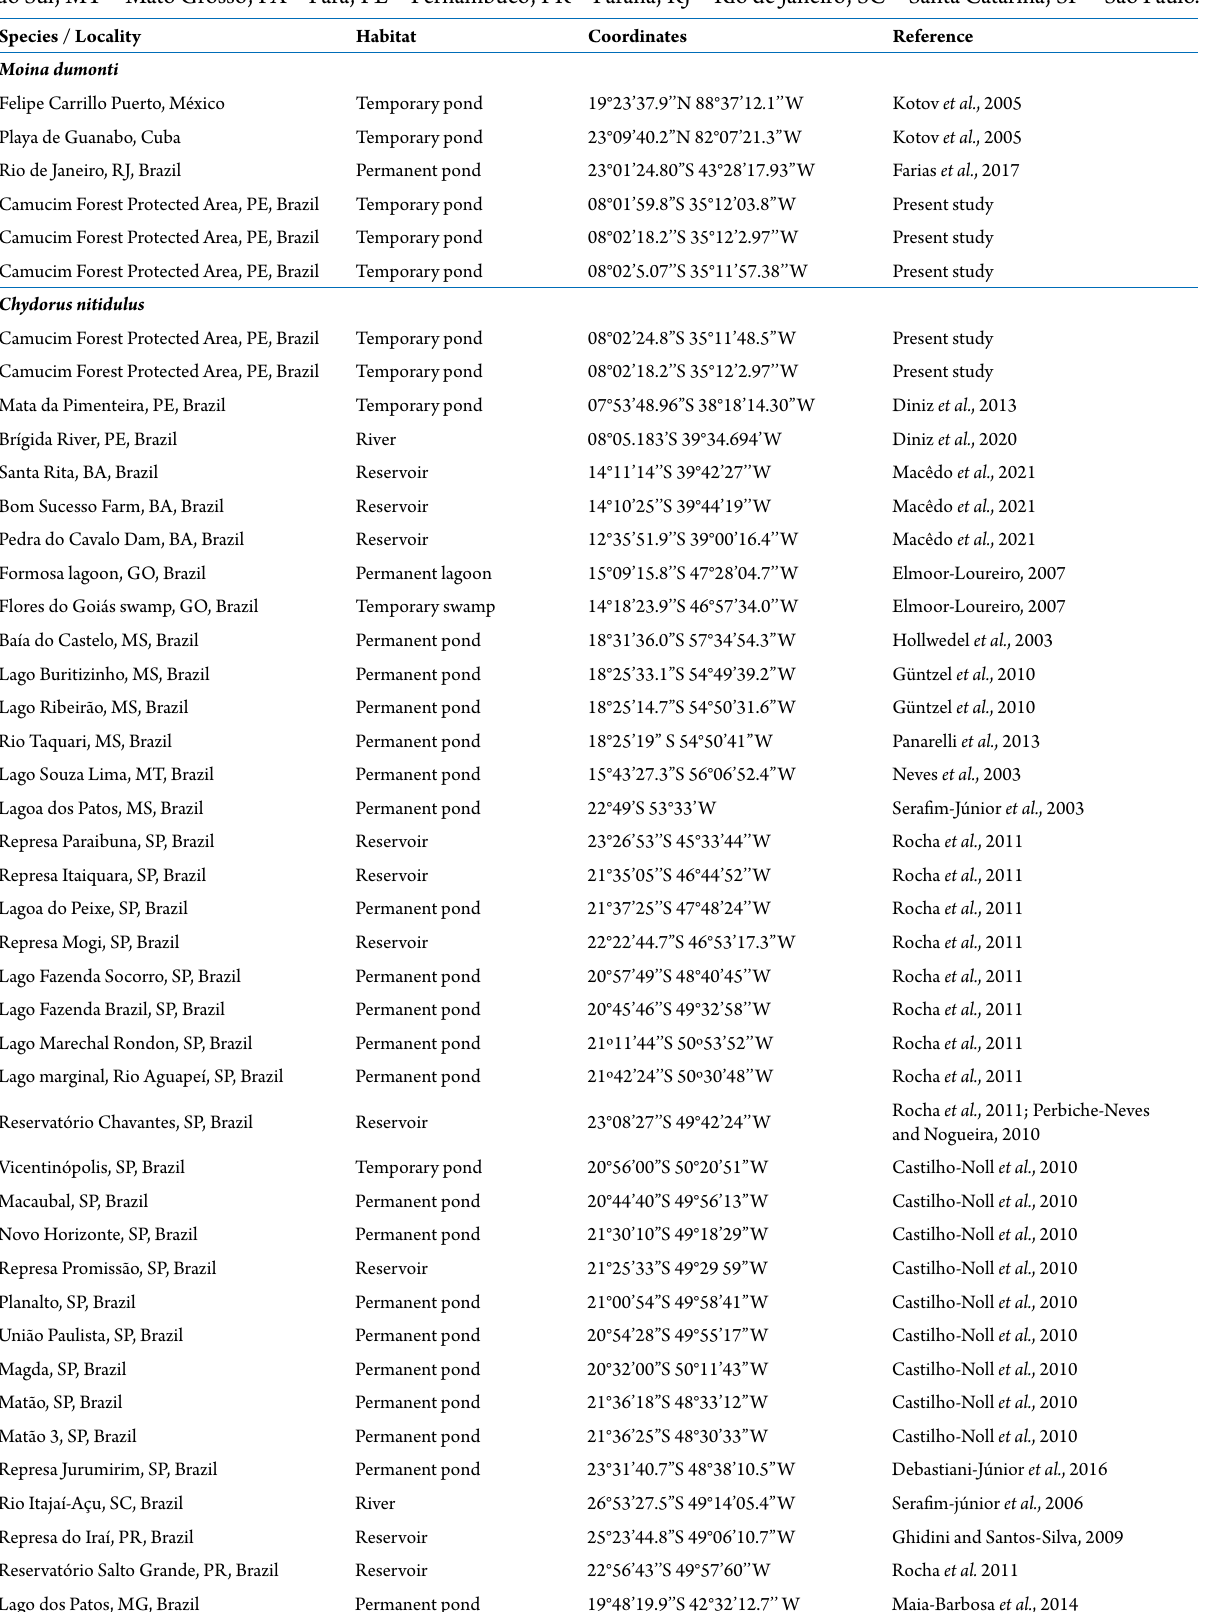
Table 1. New and previous records of Moina dumonti Kotov, Elías-Gutiérrez and Granado-Ramírez, 2005 and Chydorus nitidulus (Sars, 1901) in Neotropical regions. Abbreviations for Brazilian States: BA = Bahia; GO = Goiás; MG = Minas Gerais; MS = Mato Grosso do Sul; MT = Mato Grosso; PA = Pará; PE = Pernambuco; PR = Paraná; RJ = Rio de Janeiro; SC = Santa Catarina; SP = São